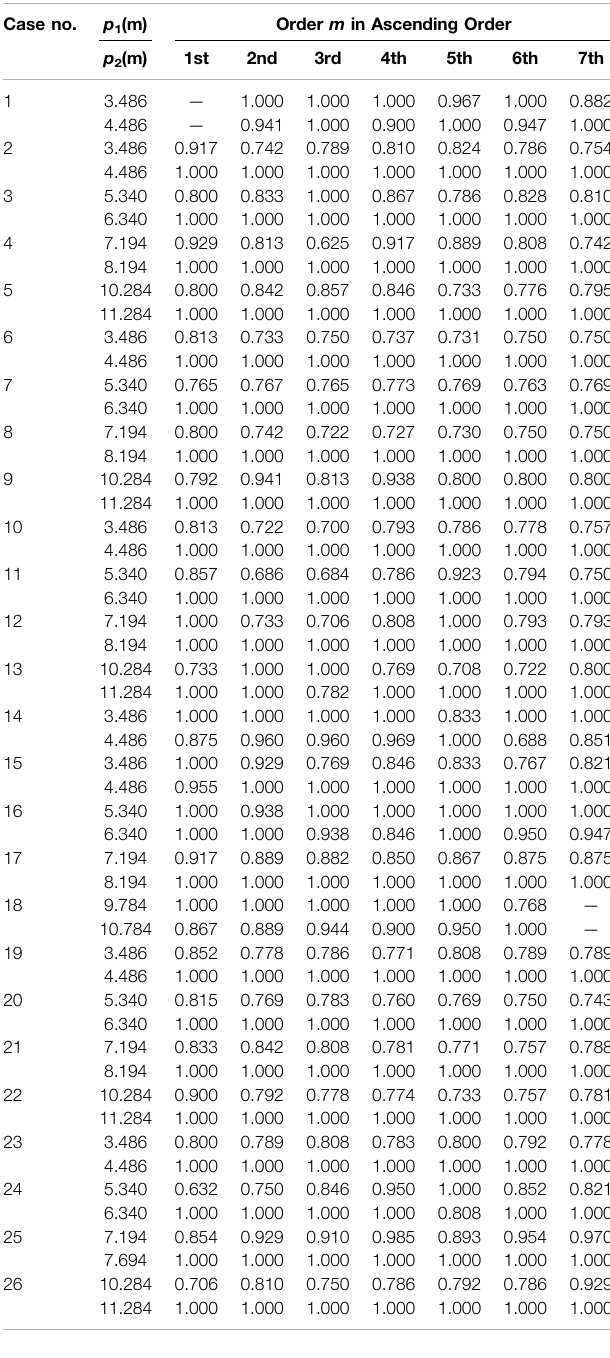
TABLE10| Firsttoseventhmeasurednaturalfrequenciesinascendingorder(Hz). Case no.